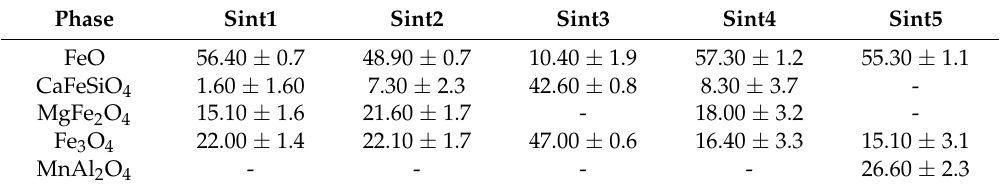
Table 5. Quantitative analysis of the phases available in the sample discounting amorphous